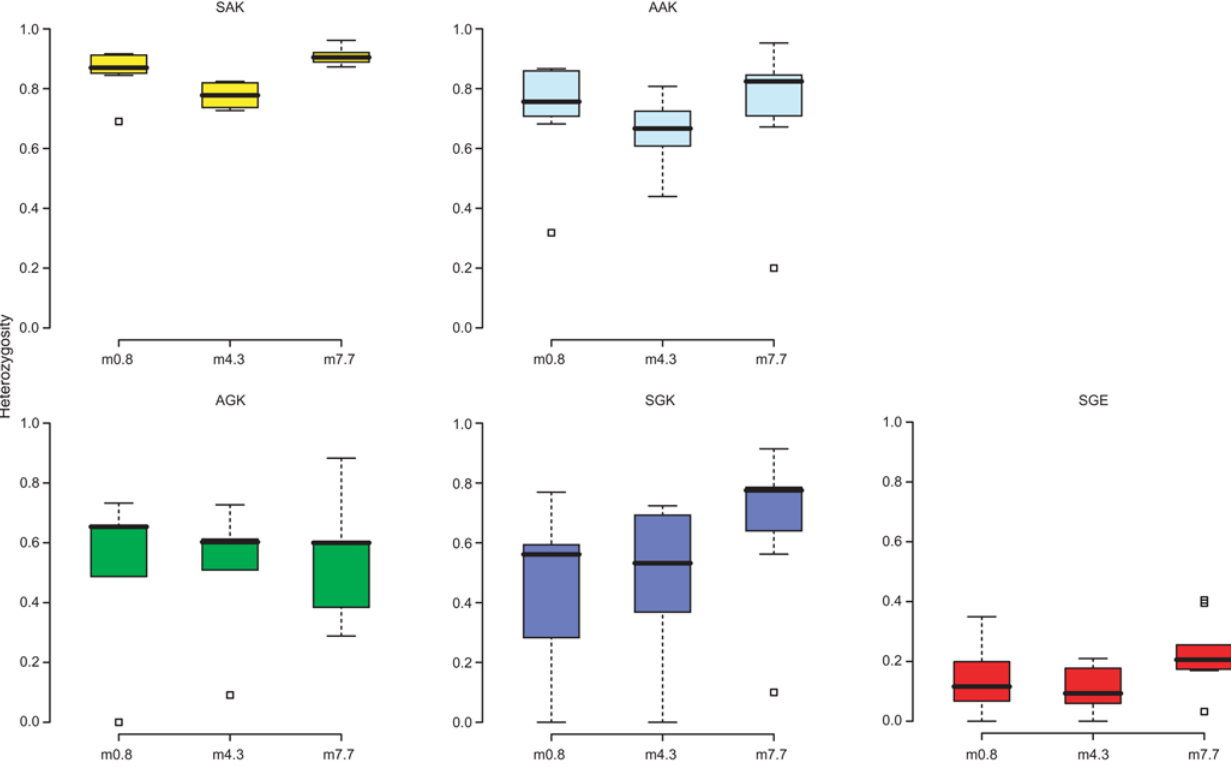
Figure 3. Microsatellite diversity around the wild-type (SAK and AAK) and the resistant (AGK, SGK, and SGE) alleles. The expected heterozygosity ( H e ) at flanking loci 0.8 kb, 4.3 kb, and 7.7 kb from the dhps gene was calculated for each geographical site (provided the number of observation $ 10), and box plots show the median, interquartile ranges, and the upper and lower extremes of the distribution of H e values among geographical sites. Where there are statistical outliers, these are indicated by small squares.